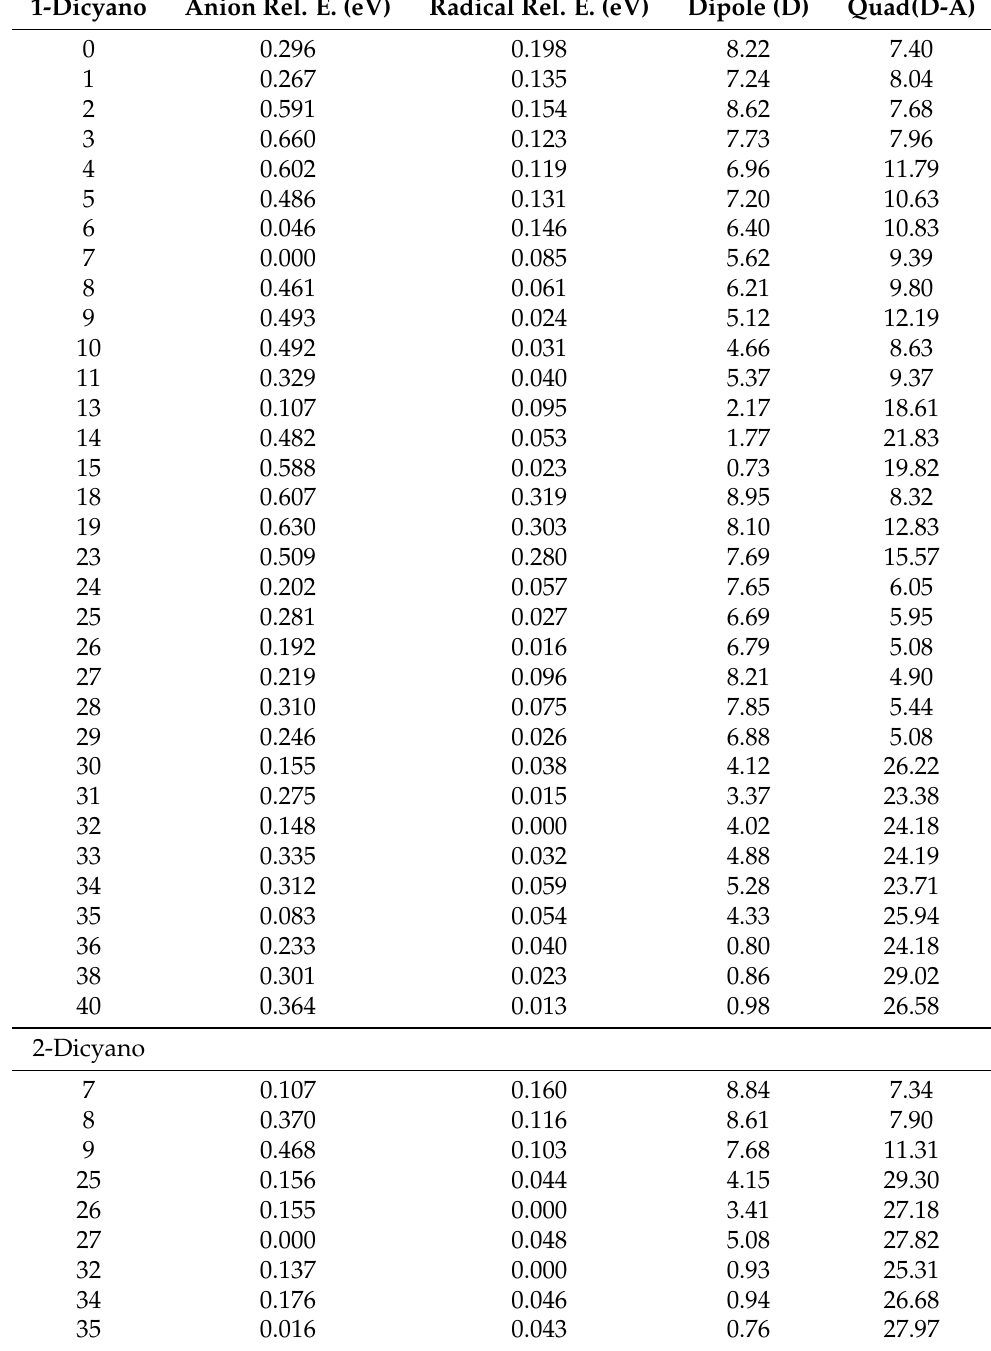
Table 3. Relative energies along with the total dipole moments and largest quadrupole moment contributions of the dicyano naphthalene